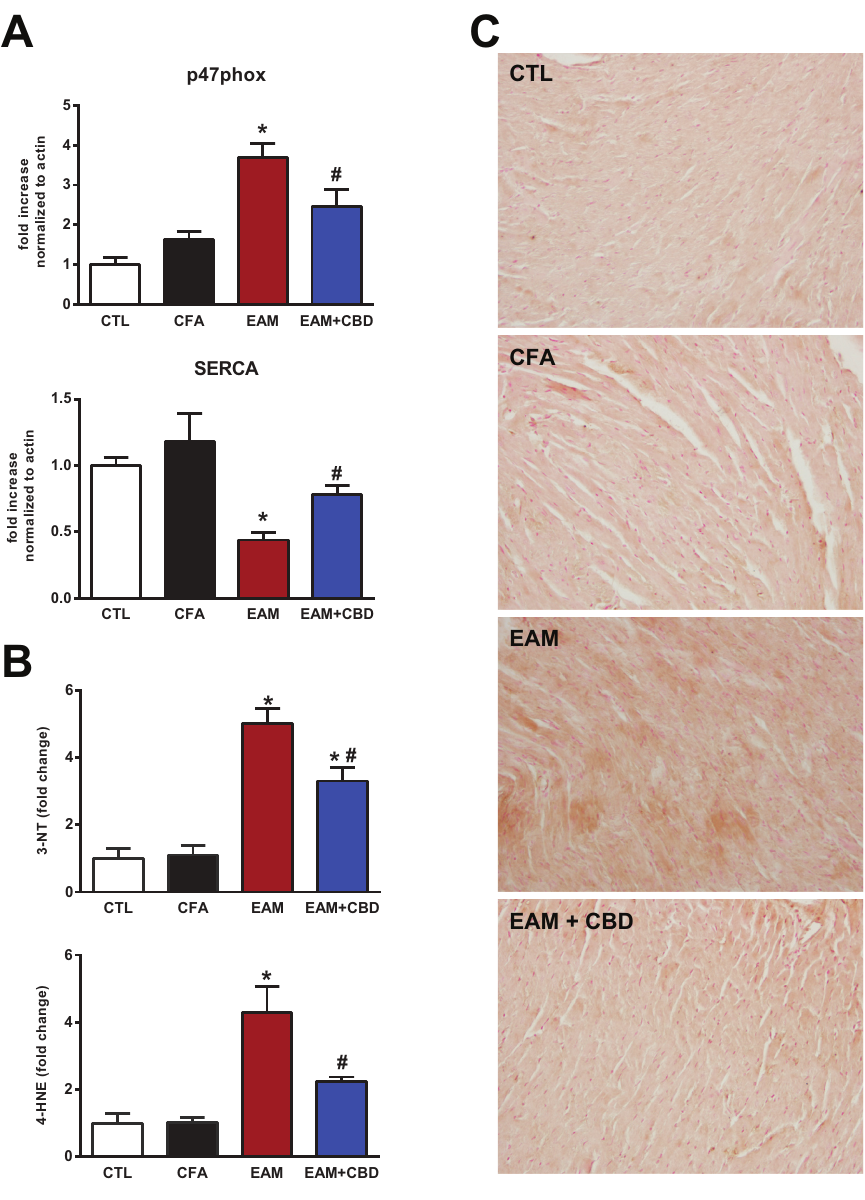
Figure 4. Effects of CBD on oxidative stress and inflammation in EAM. (A) Cardiac mRNA expression of oxidative stress markers (p47phox and SERCA). (B) Myocardial 3-NT and 4-HNE content. (C) Representative images of cardiac 3-NT immunohistochemistry. Magnification: 200×. * P < 0.05 versus CTL; # P < 0.05 versus